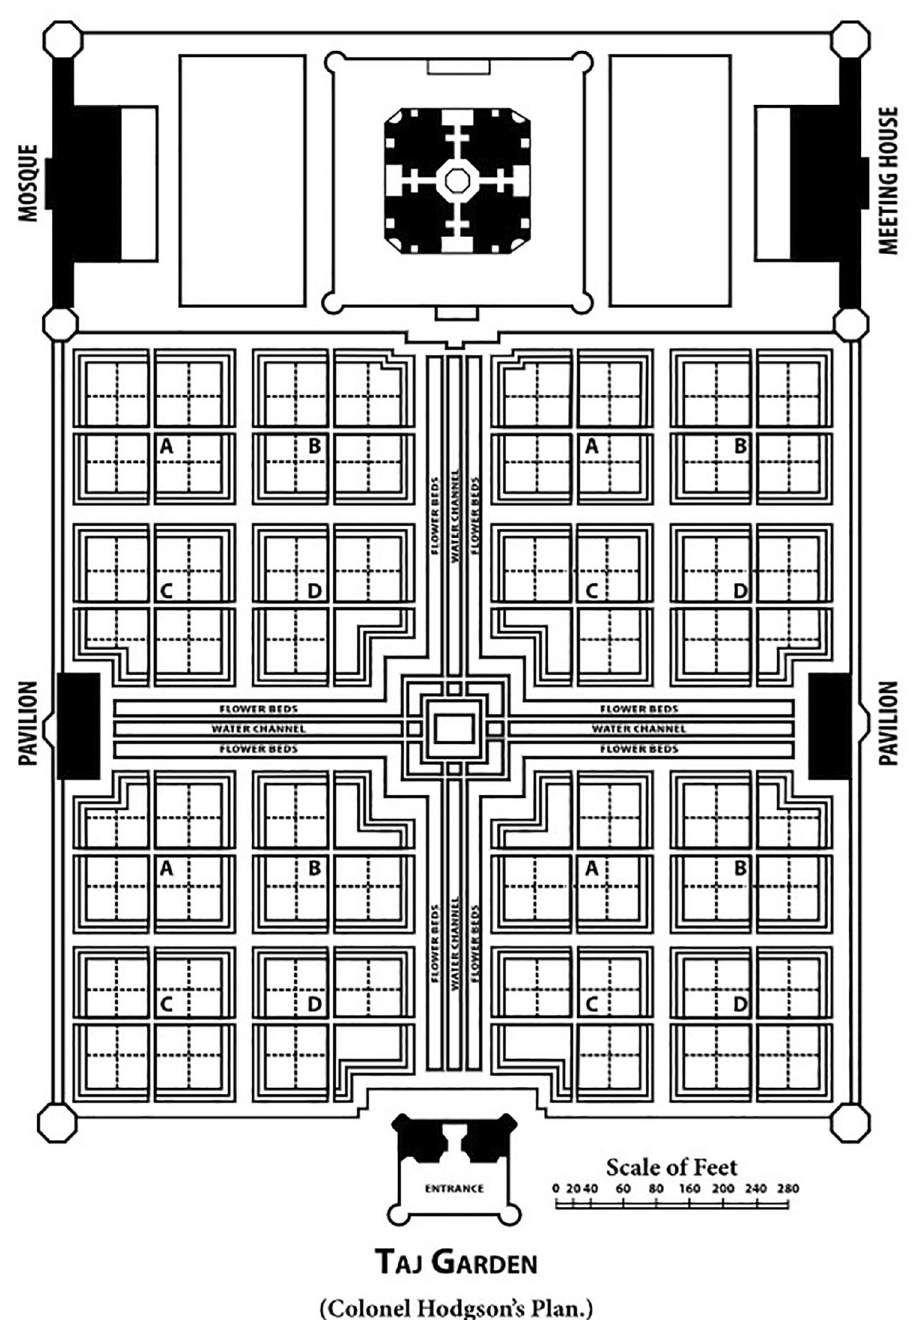
Fig. 3 Taj Mahal plan used as the basis for the fractal analysis. Source: Col. Hodgson ’ s survey plan (1828). TajPlanMughalGardens.jpg: Villiers Stuart derivative work: Fred the Oyster/Public domain. : https://commons.wikimedia.org/wiki/File:GreatMughalsTM_(complete).svg [Accessed 1 June 2019].